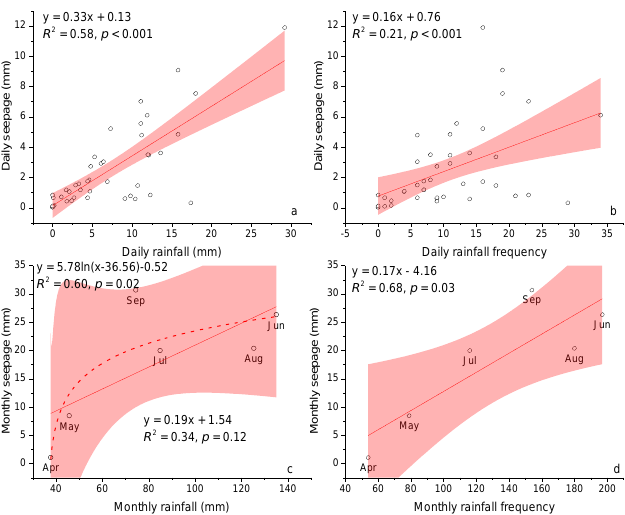
Figure 4. The relationships between soil seepage amount, rainfall amount ( a , c ), and rainfall frequency (rainfall–fre, b , d ) at the daily ( a , b ) and monthly ( c , d ) scales. The shading areas show the 95% confidence of the regression line. Table 1. The forward stepwise linear regressions for the daily soil seepage amount in the summer pasture of alpine meadow (Rain: rainfall amount, Rain–fre-2: the 2–day rainfall frequency before soil seepage). Model